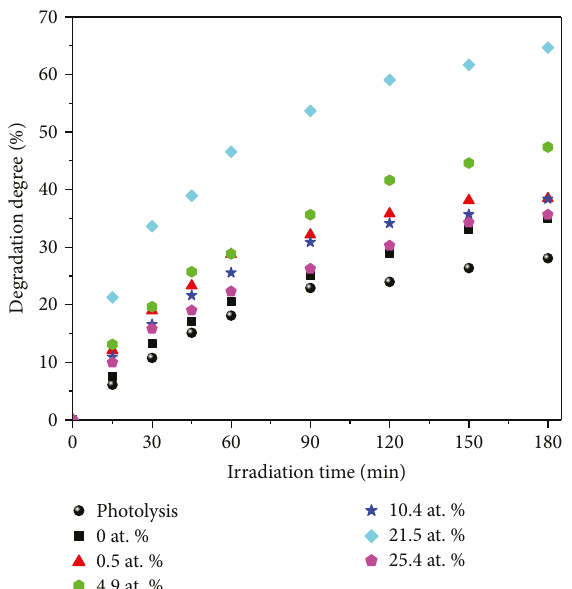
) for photocatalytic formulations app